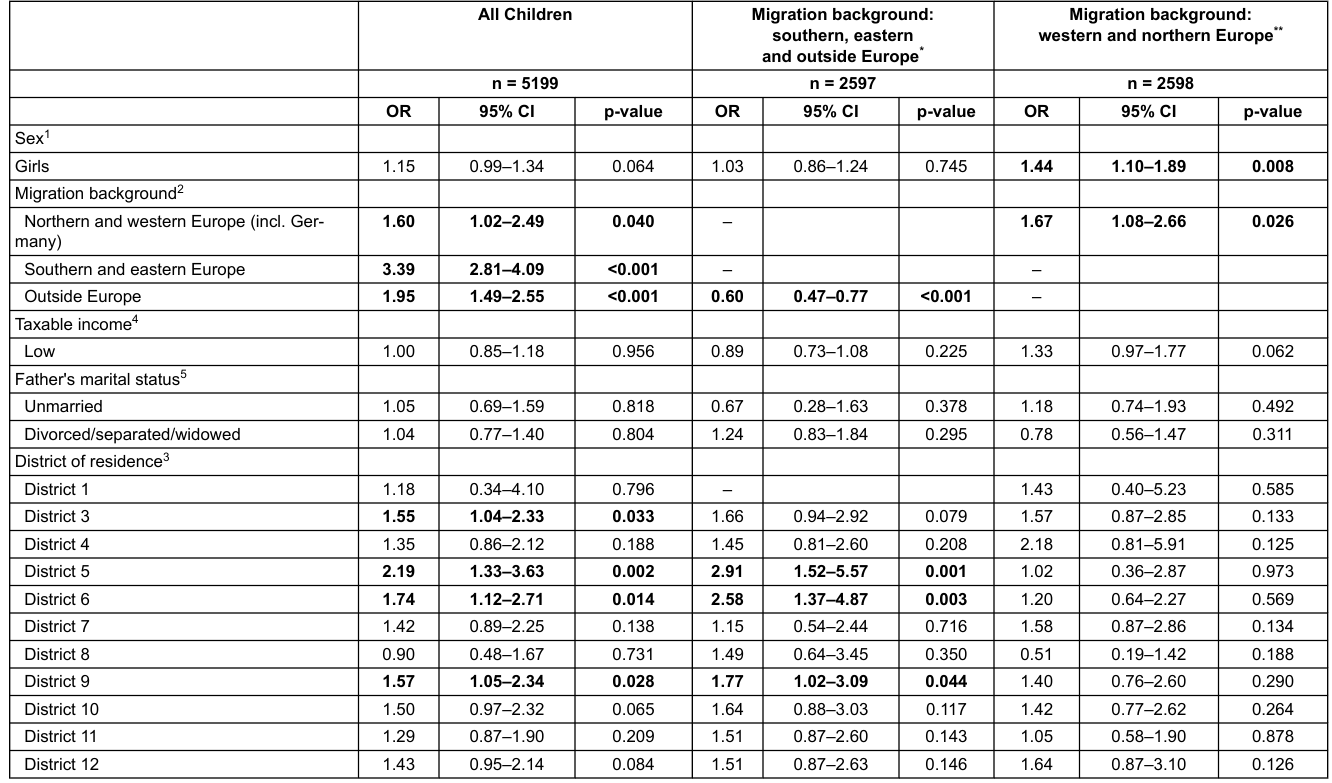
Table 3: Odds ratios (95% confidence intervals) for children being overweight/obese at school entry, based on sociodemographic variables and stratified for migration back- ground.